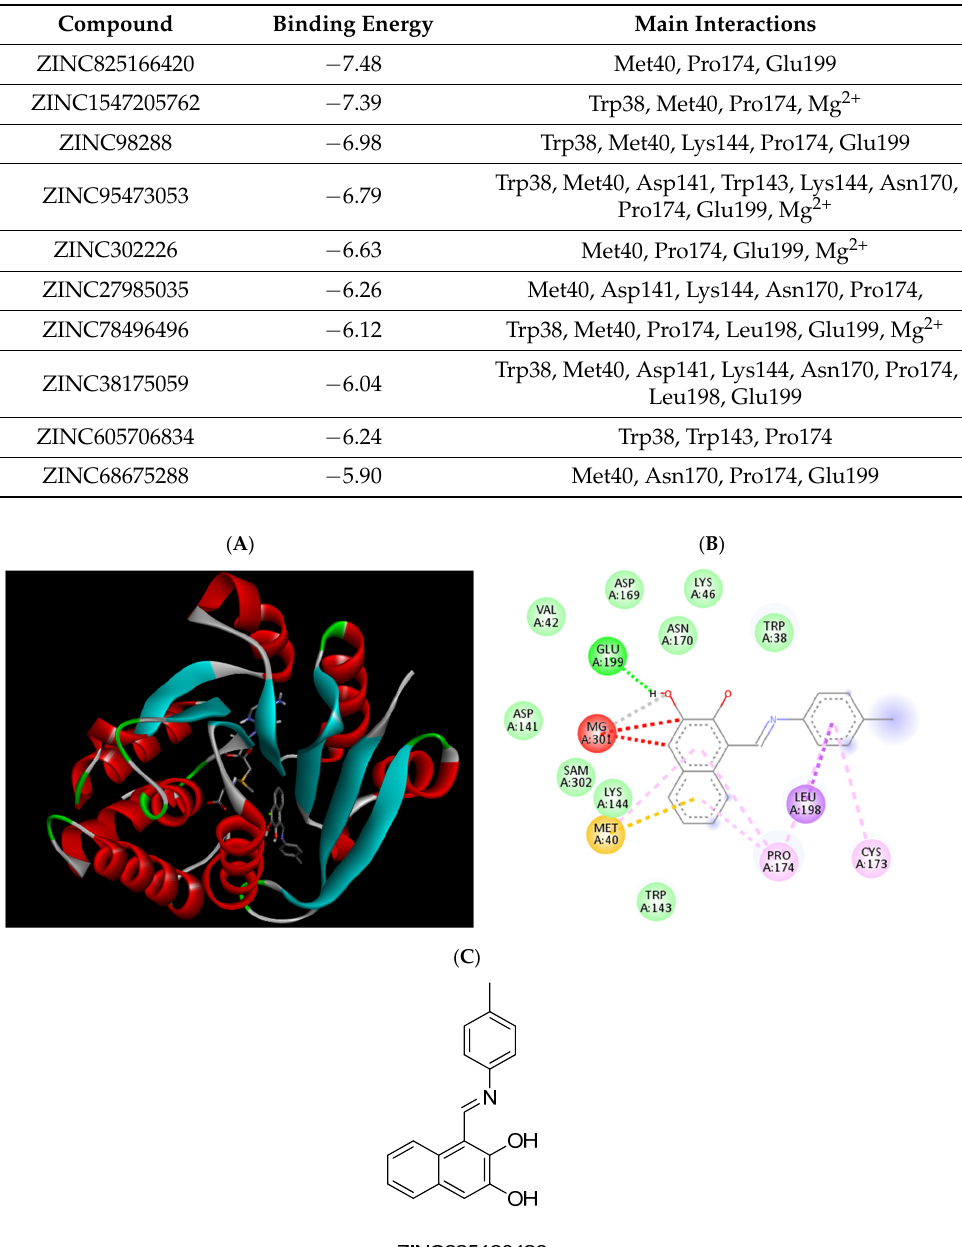
Table 1. Hit molecule predicted values of the binding affinities and main interactions with the target.